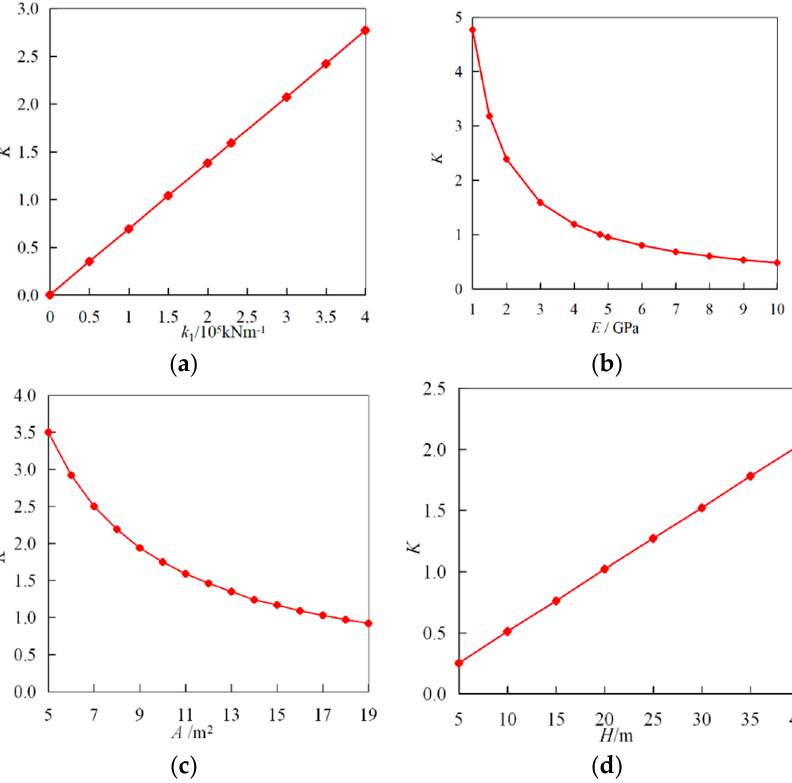
Figure 12. Analysis of influence factors of stiffness ratio K.